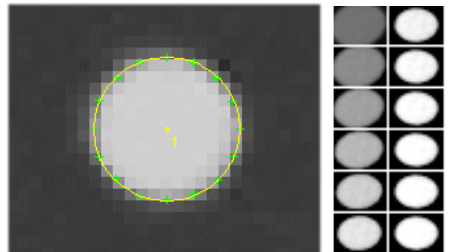
Figure 5: Result of ellipse operator (left) and template matching (right)